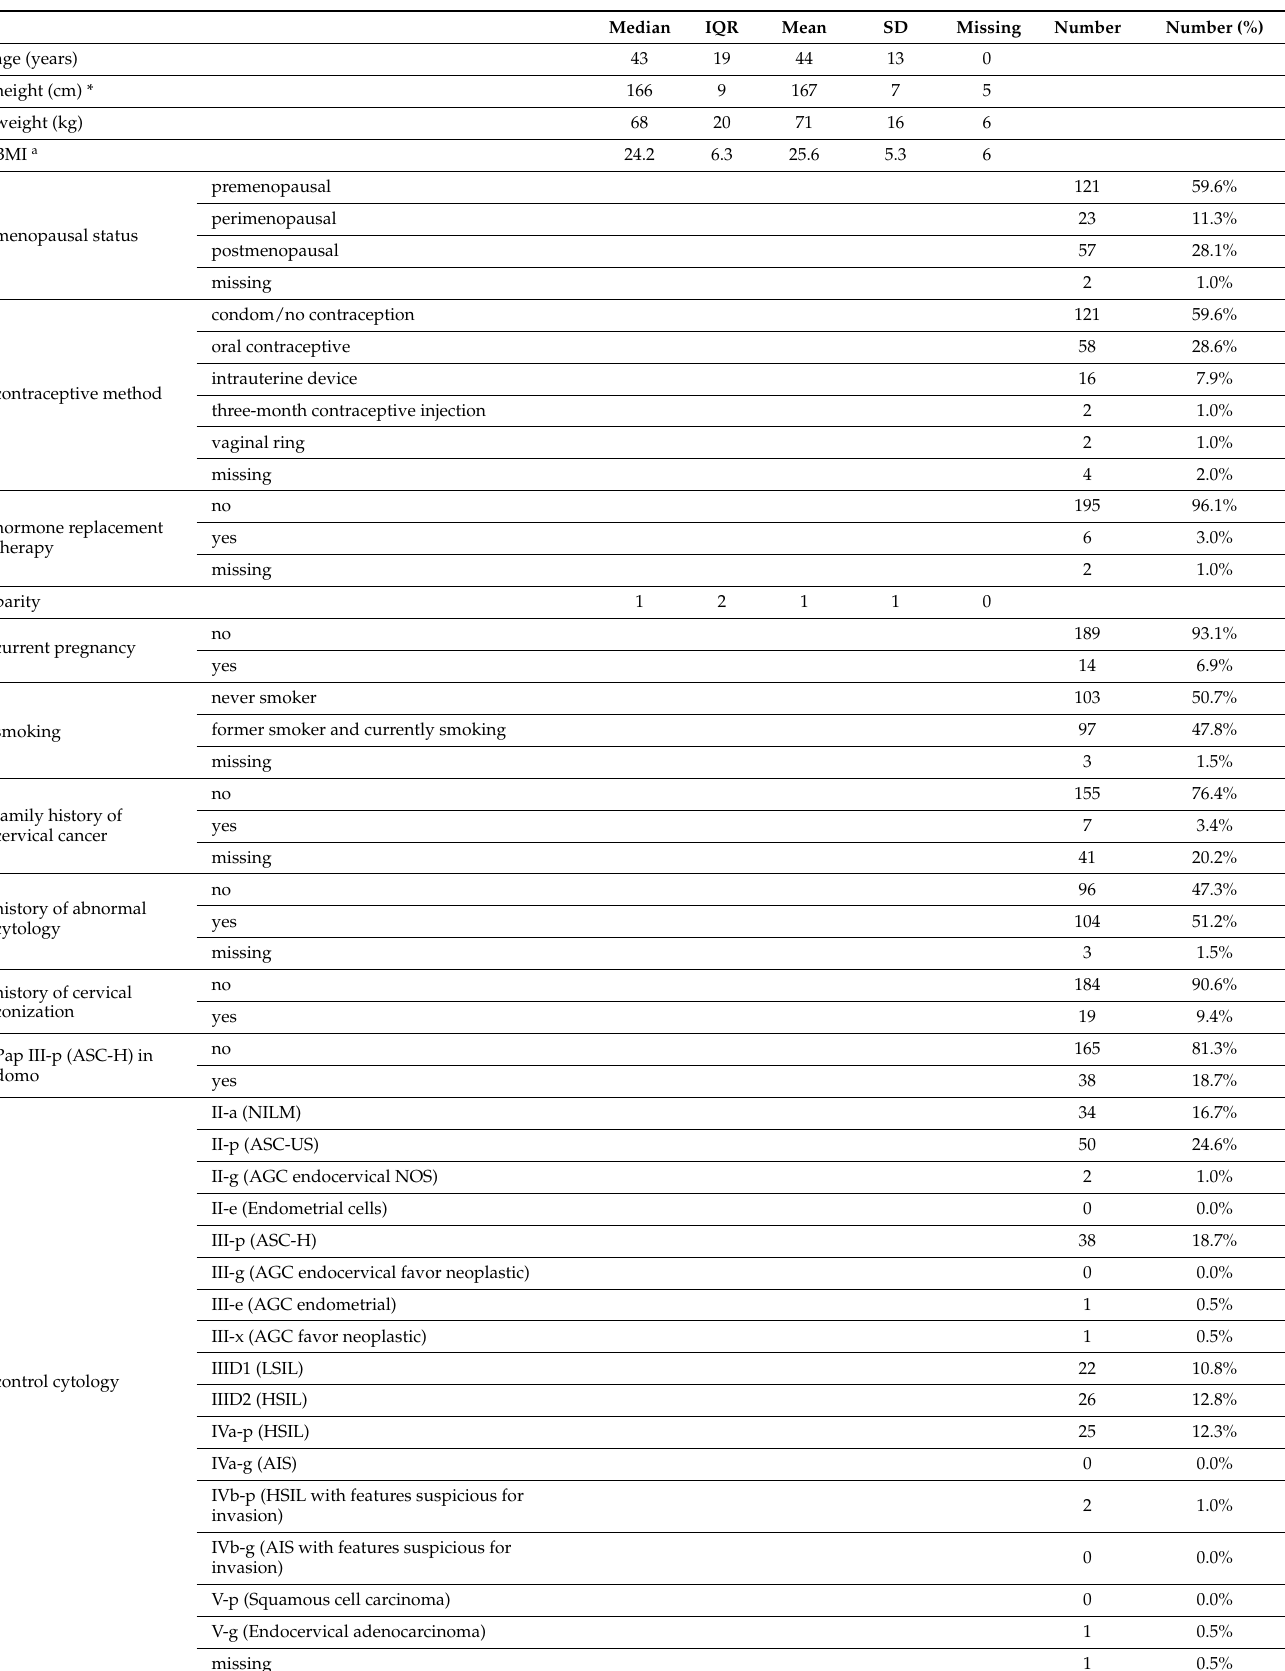
Table 1. Baseline